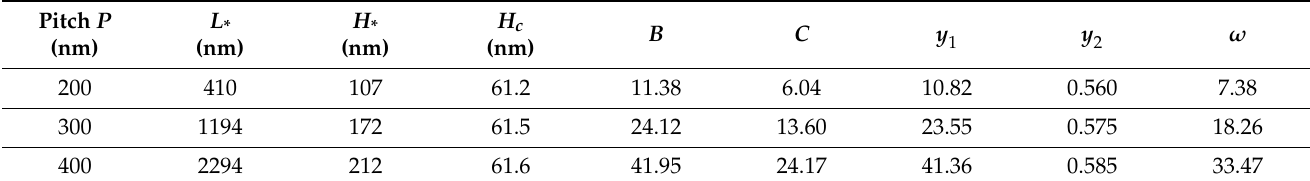
Table 1. Parameters used in Figure